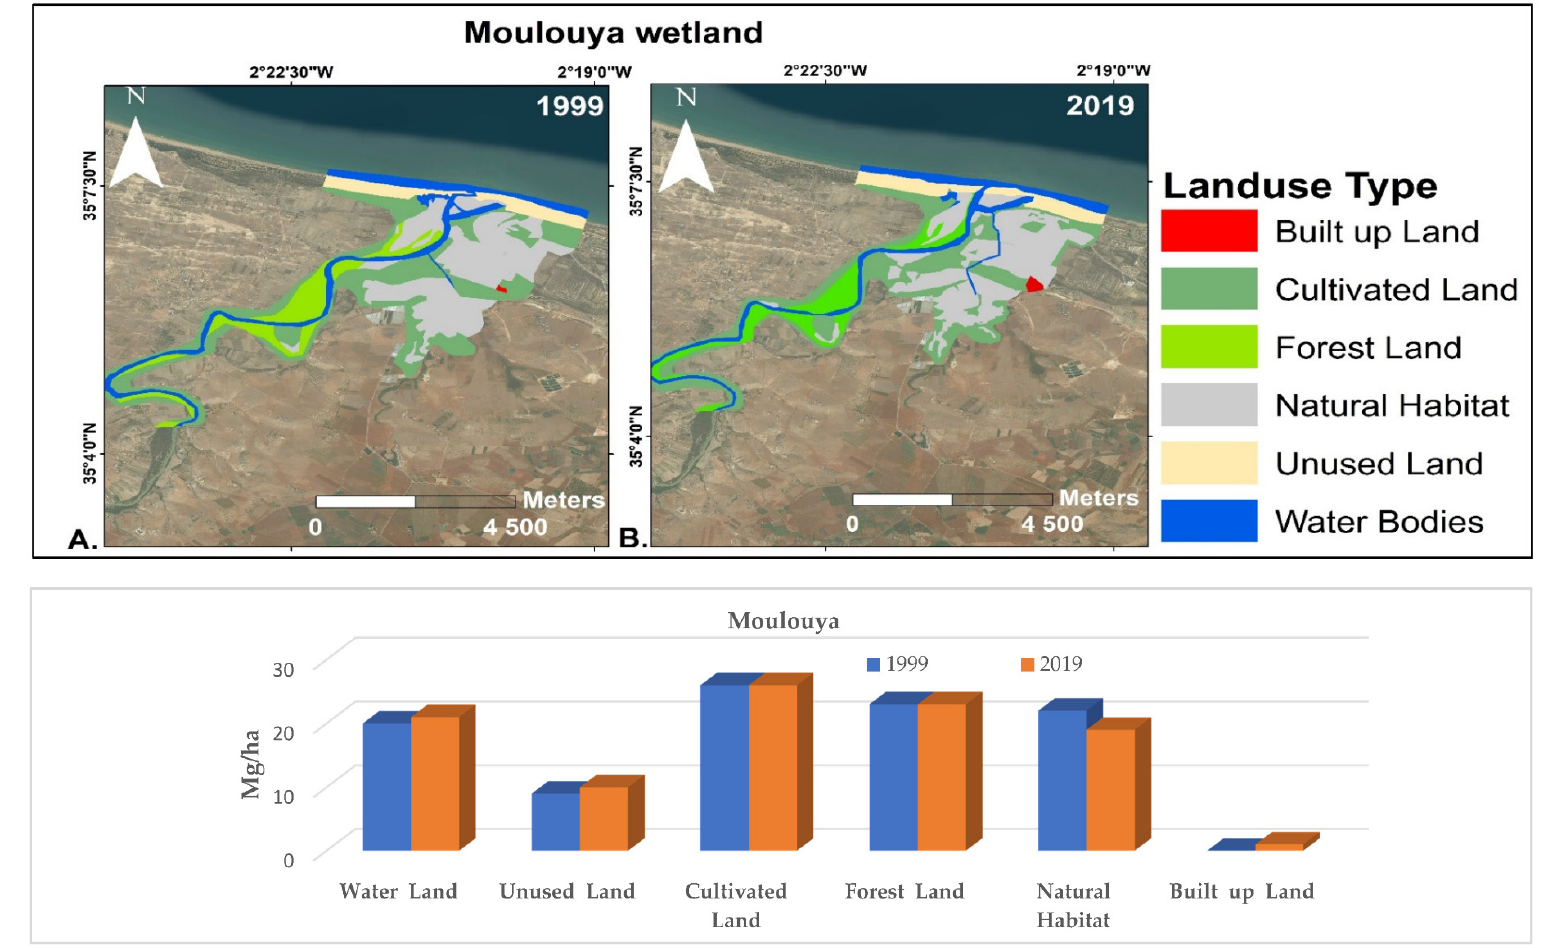
Figure 6. Maps and percentages of LULC changes in Moulouya between 1999 and 2019: ( A ) LULC change of 1999; ( B ) LULC change of 2019 .